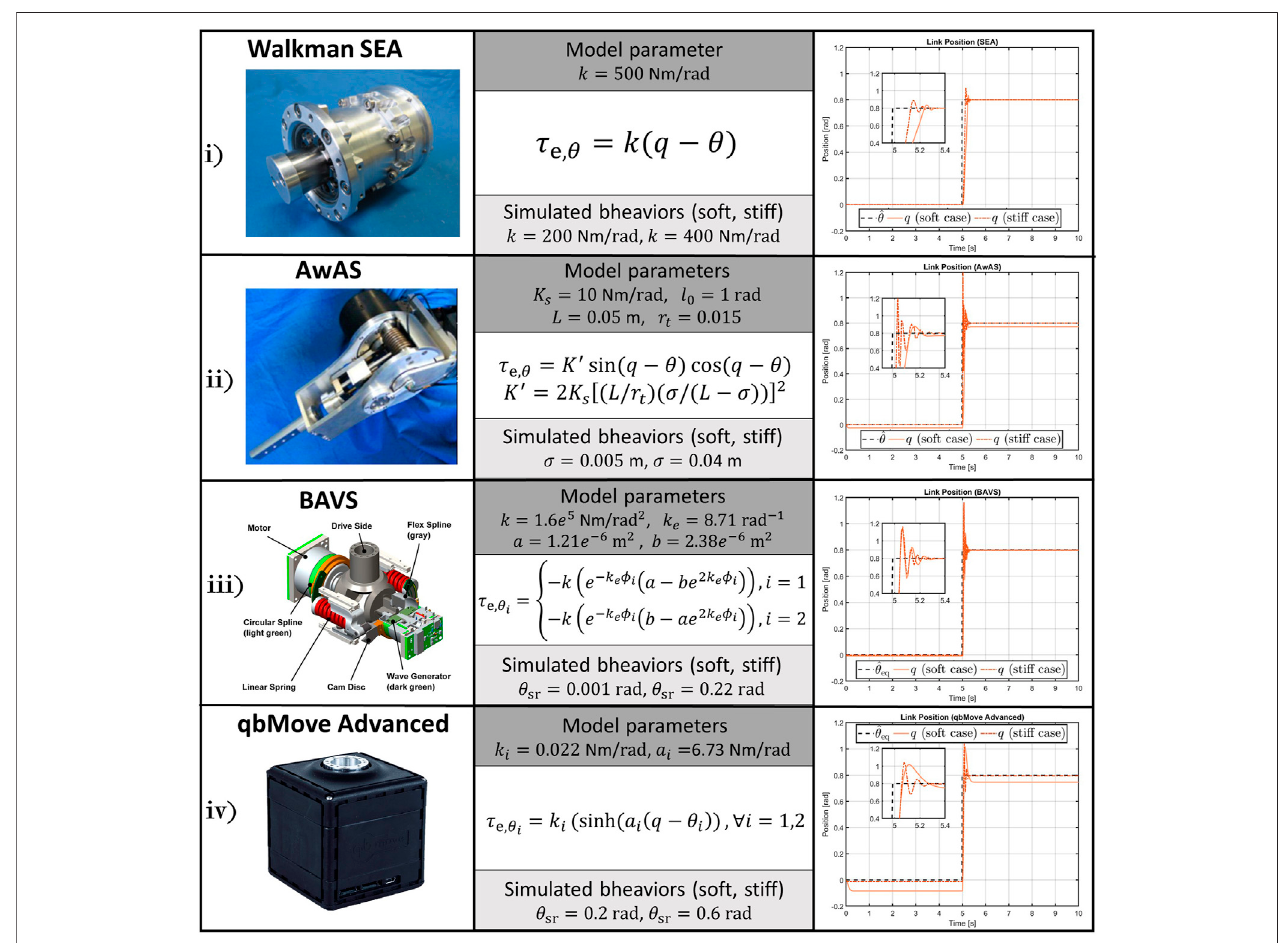
FIGURE 7 | VIACTORS ’ s compliance models implemented in theROS-Gazebotoolbox and simulation results to the step response performed with different compliantbehaviors(right-handcolumn).The1-DOFstructuressimulateamassof0.2 kgattachedtotheoutputlink,withthecenterofmasslocatedat0.04 mw.r.t.the joint axis, subjected to gravity.